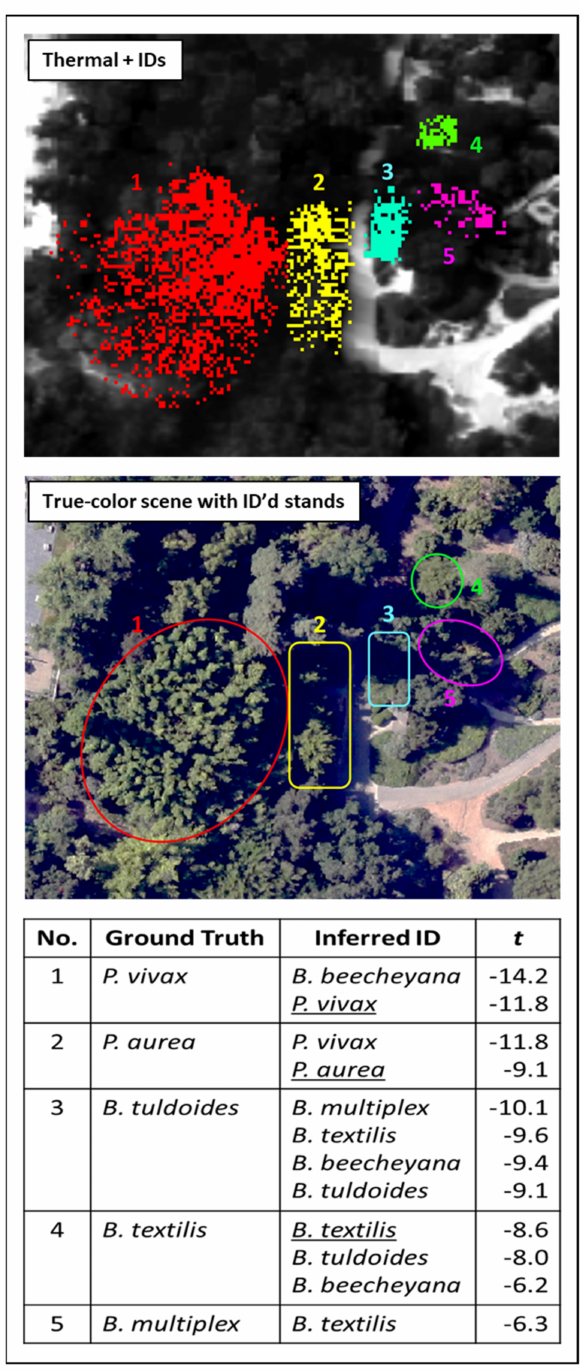
Figure 20. Detection images of multiple bamboo taxa showing the range of IDs obtained with each